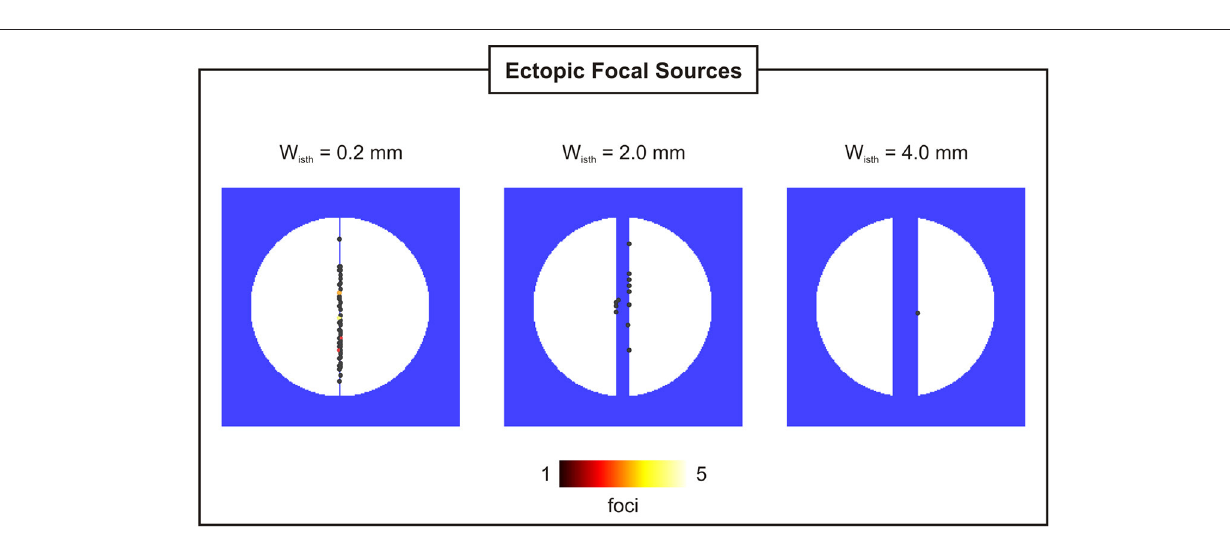
the isthmus (43 ms compared to 25 ms with no fibrosis). It can be seen at time t = 850 ms that clusters of cells in isthmus as well as in the BZ (areas enclosed by circles) are not activated by the wavefronts since they are separated from the rest of the conducting tissue by